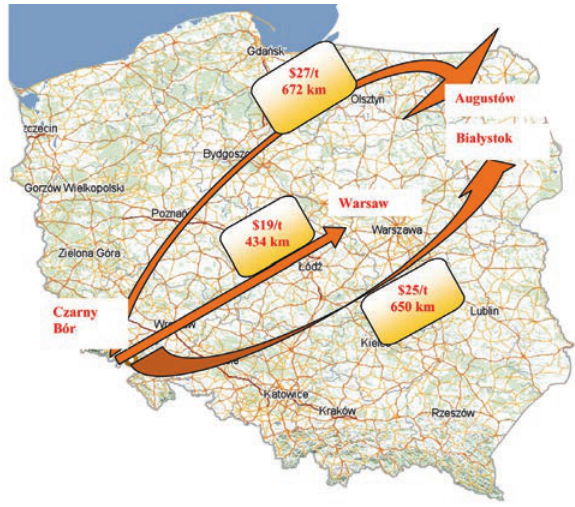
Fig. 8. Comparison of hauling price and distance for aggregates from south of Poland